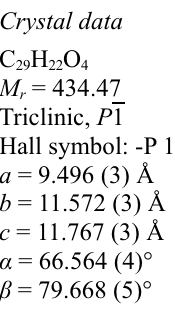
Figure 2 The molecular packing viewed down the a -axis. Dashed lines represent weak C–H···O interactions. 5,7-Bis(benzyloxy)-2-phenyl-4 H